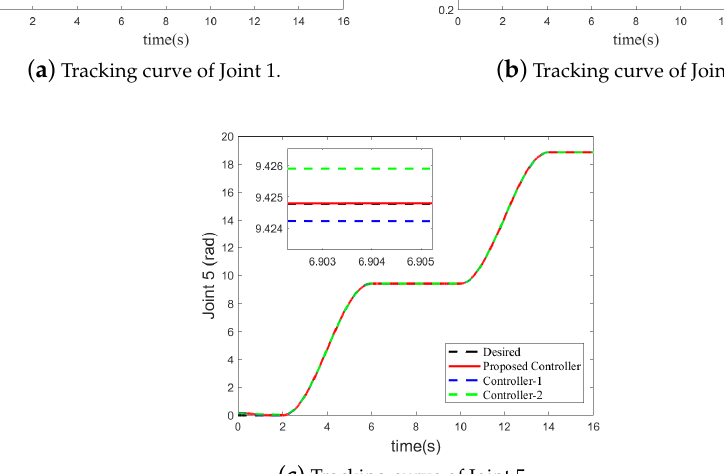
( c ) Tracking curve of Joint 5. Figure 3. Tracking curves of the unilateral active joints under the three